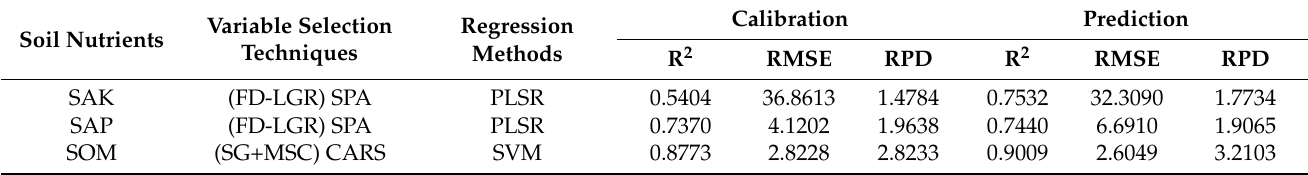
Table 3. Summary statistics of soil nutrients in the calibration and prediction